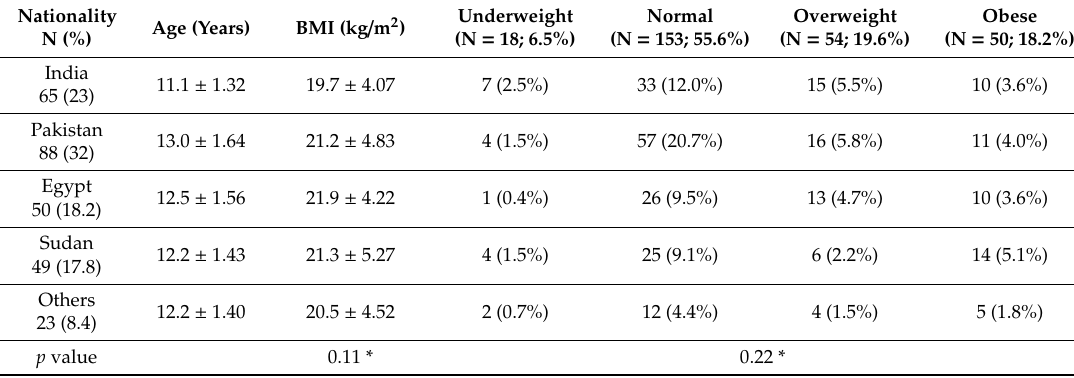
Table 1. Descriptive analysis of the participants.